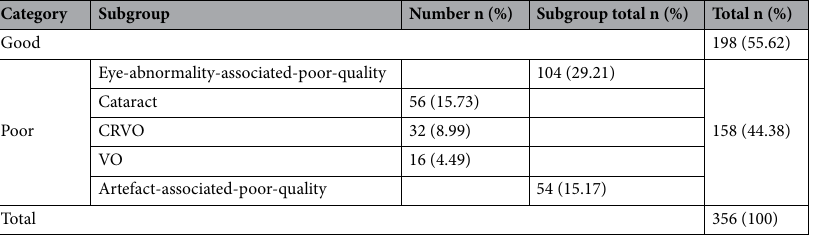
Table 4. Summary of images in the external validation dataset taken by TOPCON TRC-NW100 non- mydriatic retinal camera and TOPCON TRC-50DC retinal camera from the hospital. CRVO central retinal vein occlusion, VO Vitreous opaque.